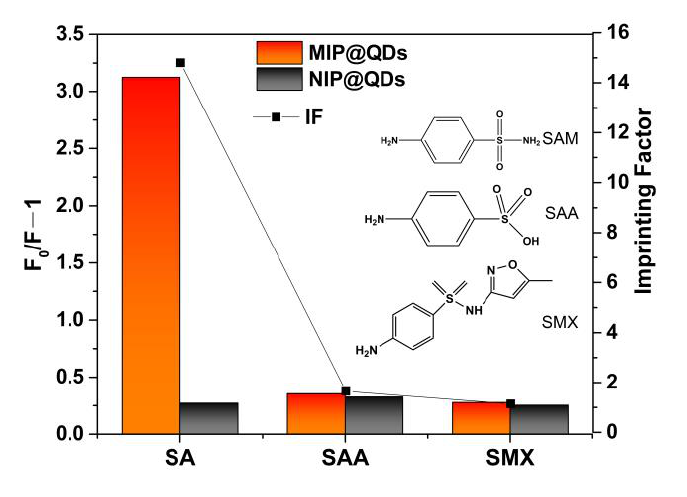
Figure 8. The fluorescence-quenching degree ( F 0 /F − 1) and the selectivity of MIP@QDs sensor (imprinting factor) for SAM, SAA, and SMX. Table 1. Detection of SAM in water samples by MIP@QDs.